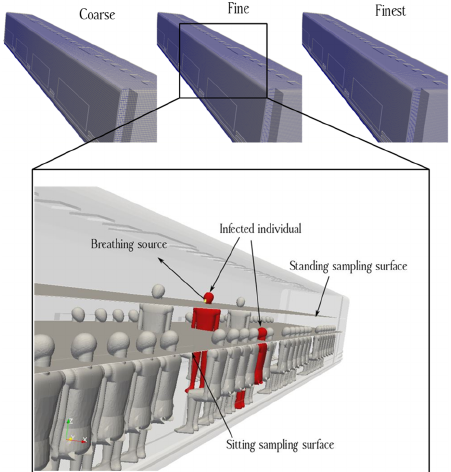
Figure 2. Schematic of a breathing source within the urban subway cabin, showing two mannequins (one standing and one seated) representing infected passengers.